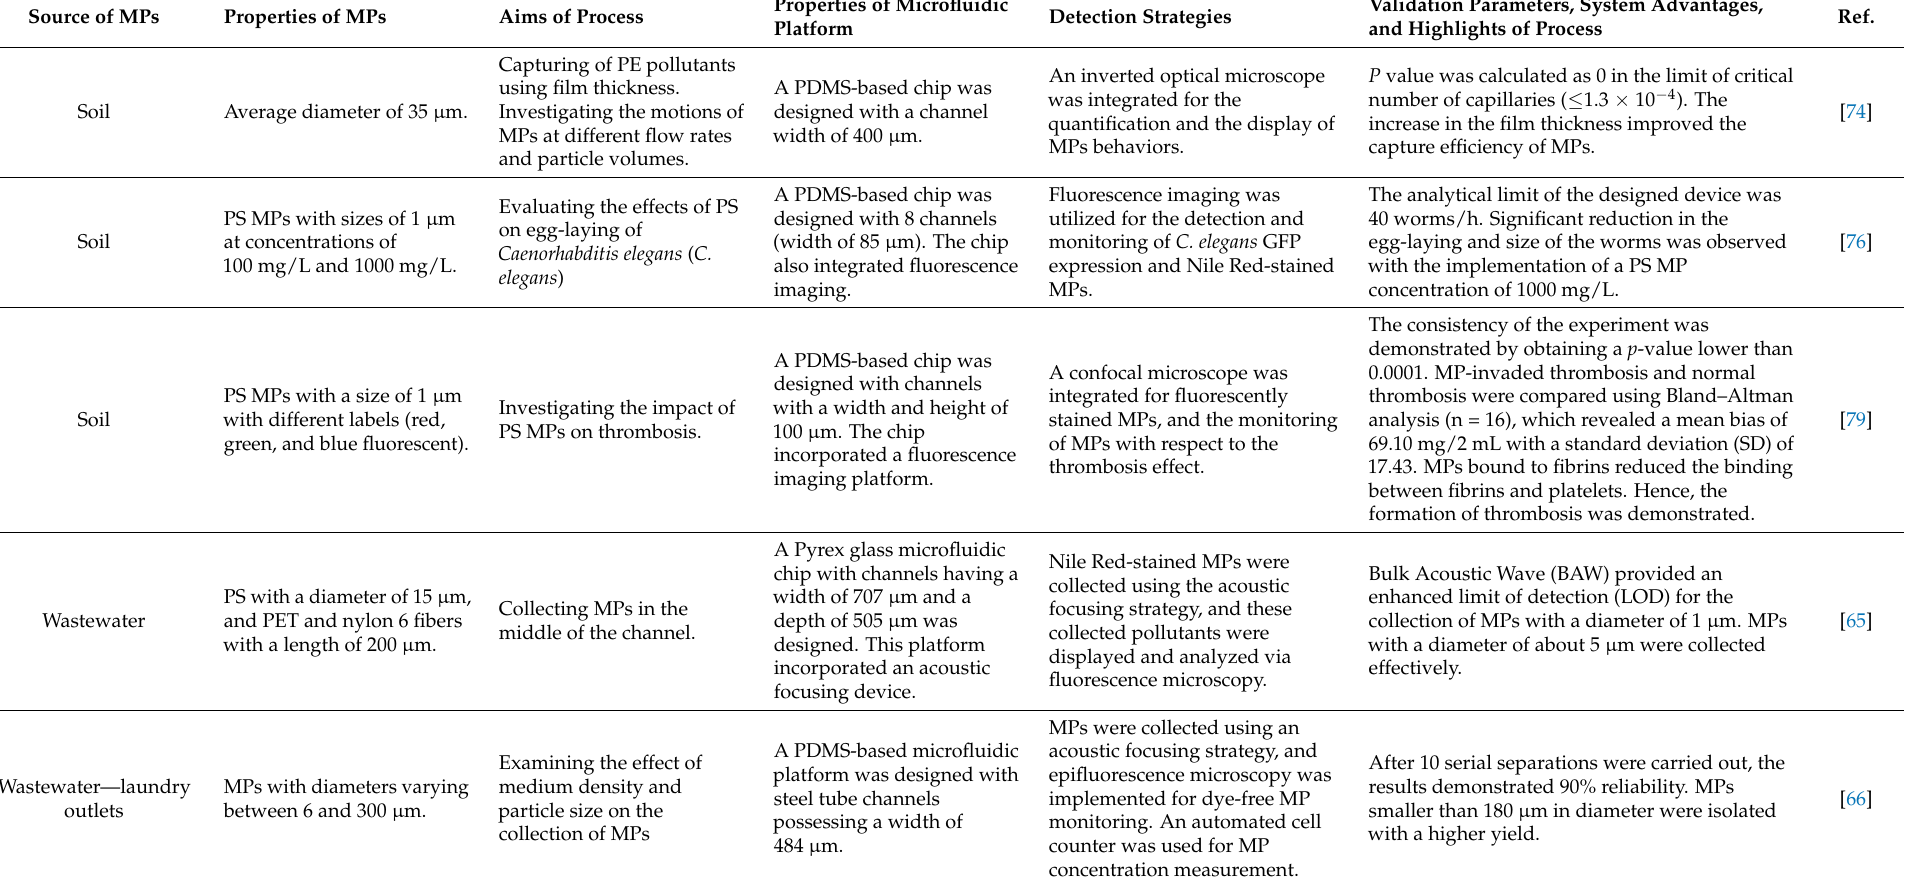
Table 2. Separation, isolation, and detection of MPs using microfluidic